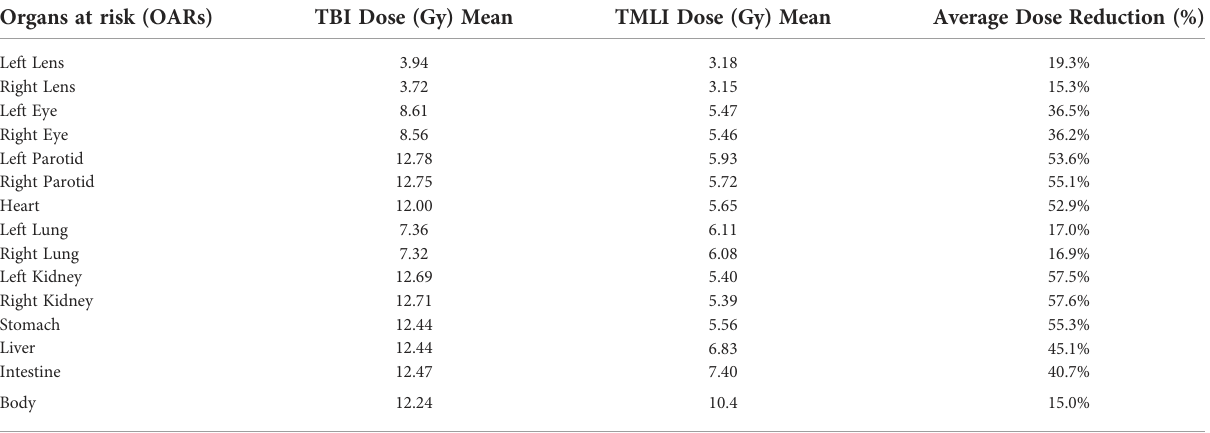
TABLE 2 Comparison of the average dose of TBI and TMLI endangered organs (12 Gy). Organs at risk (OARs)